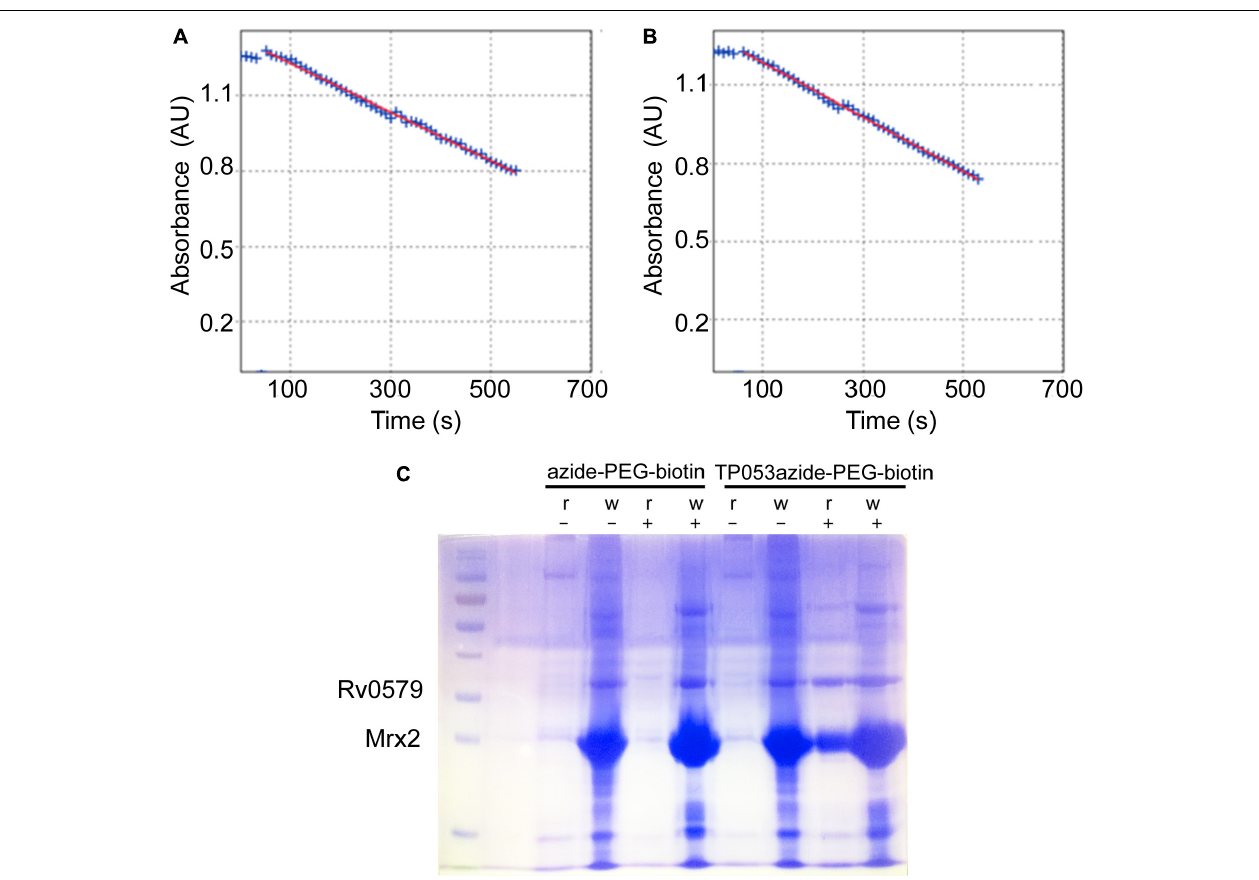
FIGURE 1 | Target fishing experiments. (A,B) The enzymatic activity assay of Mrx2 using 11526119 as a substrate (A) , was compared with the assay using TP053 (B) demonstrating that the compound retaining the same capability to be metabolized by the enzyme. Then, it was suitable for target fishing experiments. (C) SDS-PAGE analysis of the target fishing experiments. The streptavidine-agarose resin was incubated 1 h with the TP53-azide-PEG-biotin, or with azide-PEG-biotin complex, reacted with Rv0579. After the incubation the samples were washed with buffer, and both resin and wash fractions analyzed by SDS-PAGE. r, resin; w, wash; +, incubation with Rv0579 in the presence of mycothiols, to allow Mrx2 activation; –, incubation with Rv0579 without mycothiols as blank control. Rv0579 did not show any reactivity with the streptavidine-agarose resin alone, since the protein was found only in wash fractions (lanes 5 and 6). By contrast, Rv0579 was found bound the resin-TP053 complex, but only after Mrx2 activation (lane 9). This experiment demonstrates a direct interaction between the protein and the activated compound, which confirms a role of Rv0579 in resistance to